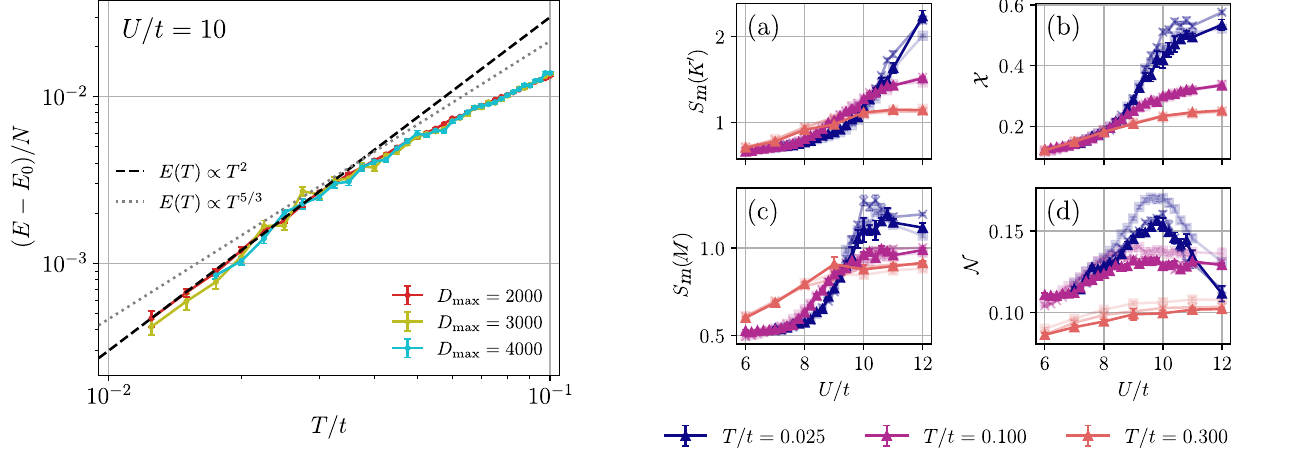
FIG. 10. Size dependence of magnetic structure factor S m ð k Þ and the chiral susceptibility X for three different temperatures. We compare YC4 cylinders of length L ¼ 16 (squares), L ¼ 24 (crosses), and L ¼ 32 (triangles). Increasing opacity denotes longer cylinder length. METTS simulations have been performed 4000 . (a) Magnetic with a maximal bond dimension D max ¼ structure factor S m ð K 0 Þ , (b) chiral susceptibility X , (c) magnetic structure factor S m ð M Þ , (d) nematic spin correlation N , from Eq. (19). We observe only weak dependence of these observables on the length L of the